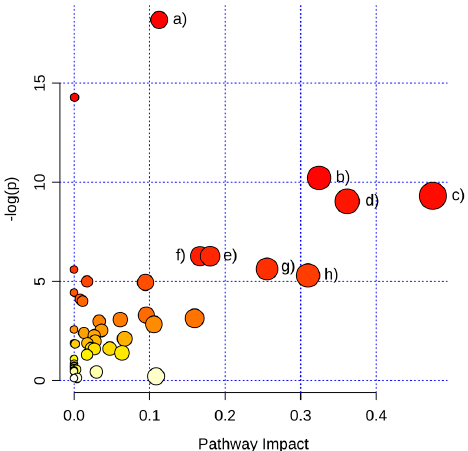
Figure 6. Map of pathway analysis shown in pathway impact and − log(p). Pathway impact